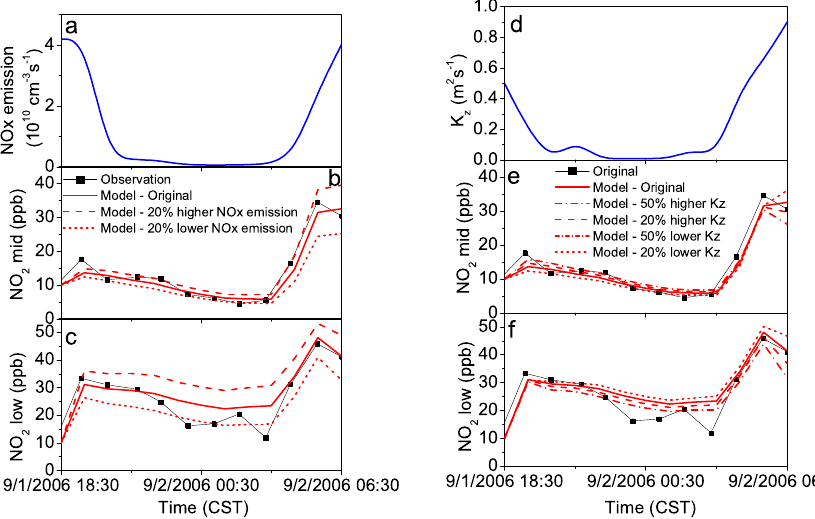
Fig. 7. Sensivity of NO 2 mixing ratios in the lower and middle light paths intervals to change in NO x emission and eddy diffusivity. NO x emission and eddy diffusivity at 10m are plotted as well.